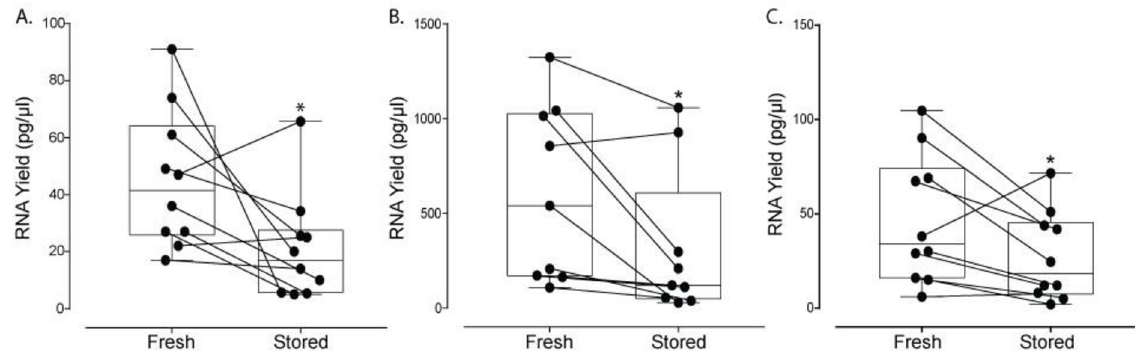
Fig 3. Impact of cryopreservation on RNA yield of plasma- and media-derived EVs. All plasma and media samples were added directly to the -80˚C freezer (without a freezing container) and thawed at room temperature. EVs from plasma were isolated using ultracentrifugation and EVs from media were isolated using qEV Columns (Izon Science). All individual data points (or biological replicates) consist of paired fresh and stored samples that were obtained from either the same individual in one blood draw (plasma-derived EVs) or same cell culture plate (media-derived EVs). Solid lines between data points link the corresponding fresh and stored samples for a given biological replicate. (A) RNA yield of plasma-derived EVs in fresh versus stored samples isolated using ultracentrifugation and extracted using the RNeasy spin columns are expressed as box-and-whiskers plots showing median, interquartile range, maxima/minima, and all individual data points (n = 10). (B) RNA yield of plasma-derived EVs in fresh versus stored samples isolated using ultracentrifugation and extracted using the miRNeasy spin columns are expressed as box-and-whiskers plots showing median, interquartile range, maxima/minima, and all individual data points (n = 9). (C) RNA yield of media-derived EVs in fresh versus stored samples isolated using qEV Columns and extracted using the miRNeasy spin columns are expressed as box-and-whiskers plots showing median, interquartile range, maxima/minima, and all individual data points (n = 10). Data were analyzed using the Wilcoxon signed-rank test (p < 0.05); an asterisk indicates statistical significance.